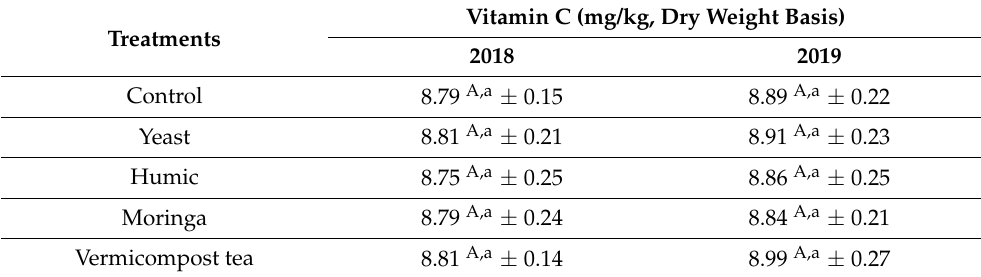
Table 12. Effect of biostimulants on vitamin C composition (mg/kg, dry weight basis) in snap bean pods in growing seasons of 2018 and